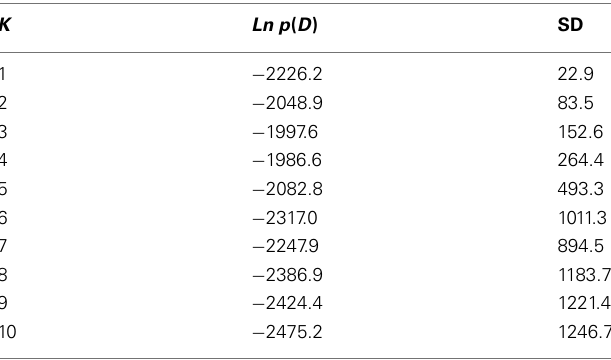
Table 7 | Population substructure estimation of 96 B. napus accessions (panel 1) by evaluating 24 SSR markers using